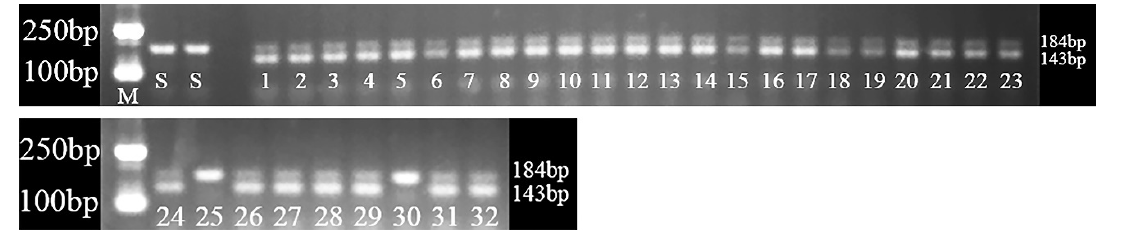
Figure 4. Electrophoretic patterns obtained with derived cleaved polymorphic amplified sequence (dCAPS) markers from 32 R Polypogon fugax plants and 2 S Polypogon fugax plants. Notes: M: DL2000 DNA Marker; S, sensitive plants; 1–32, numbering of resistant plants.